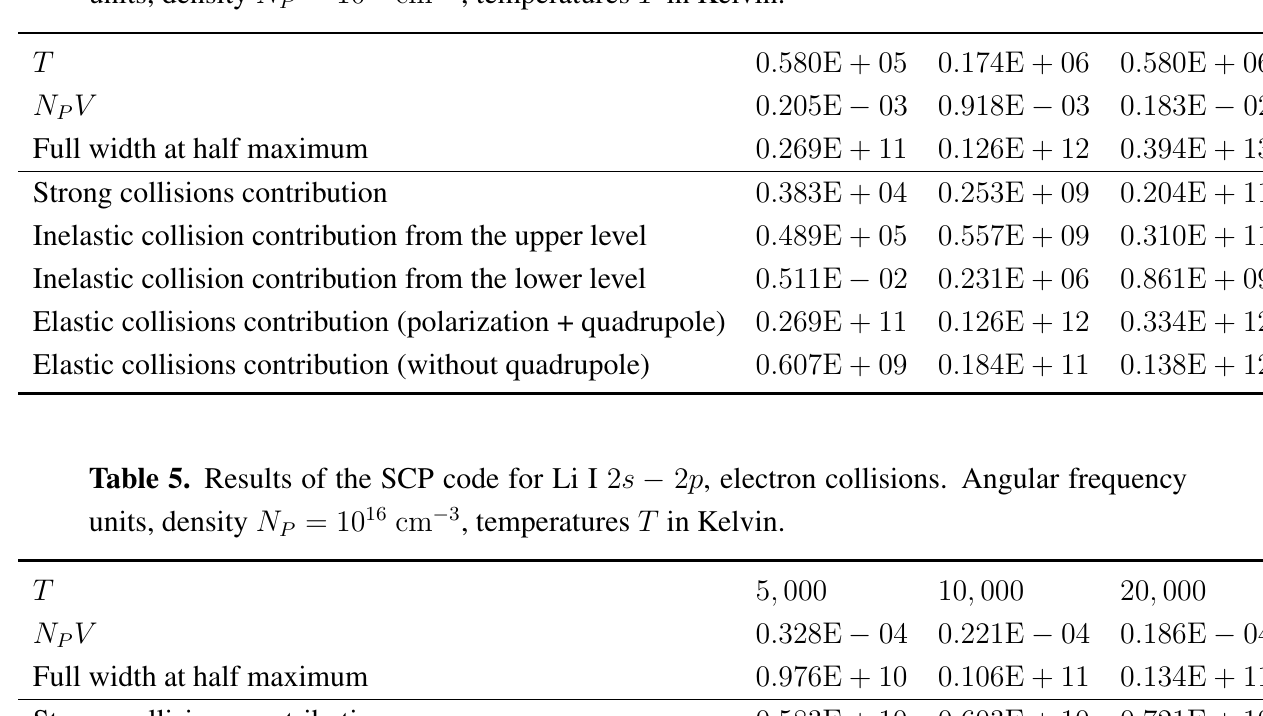
Table 4. Results of the SCP code for Ne VIII 3 s − 3 p , proton collisions. Angular frequency = 10 19 cm − 3 , temperatures T in Kelvin. units, density N P